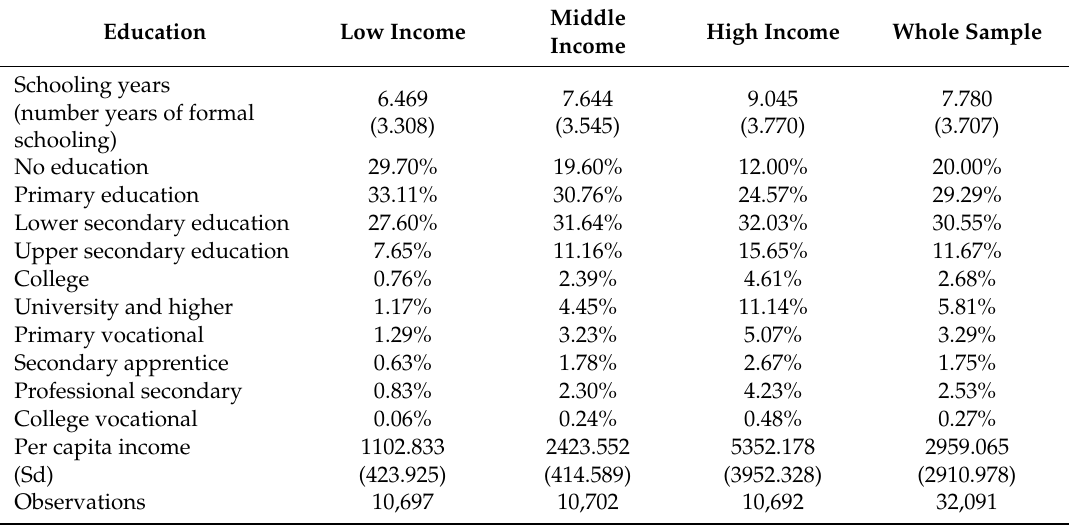
Table 1. Household heads’ education by income group.